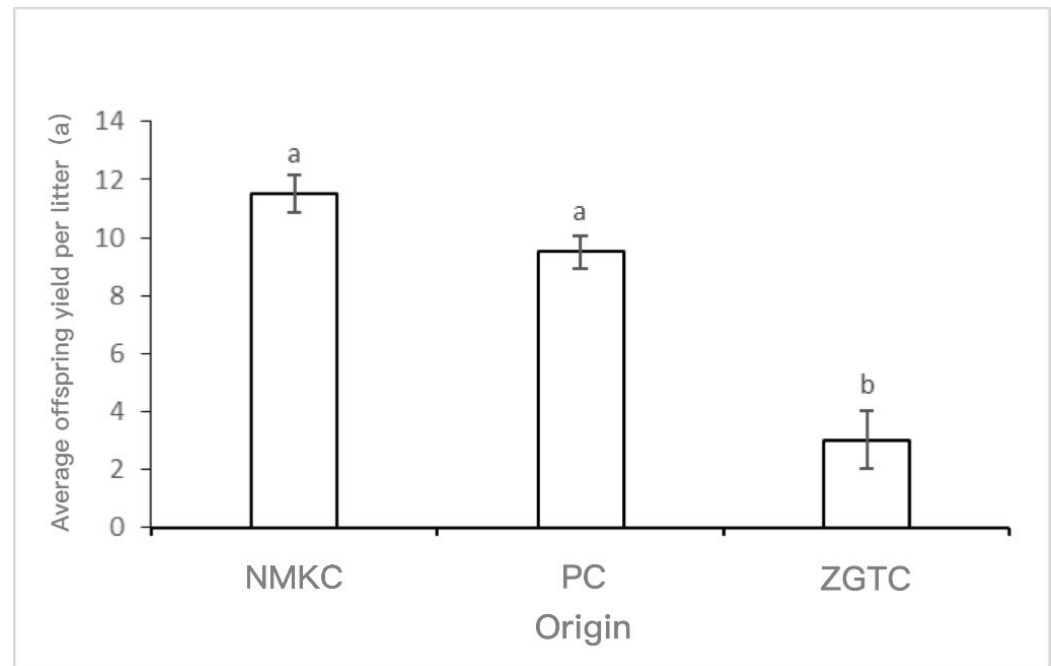
Figure 5. Prenatal development time of Daphniopsis tibetana from different origins. Means with dif- ferent lowercase letters are significantly different ( p < 0.05). a: no significant difference; b: significant difference